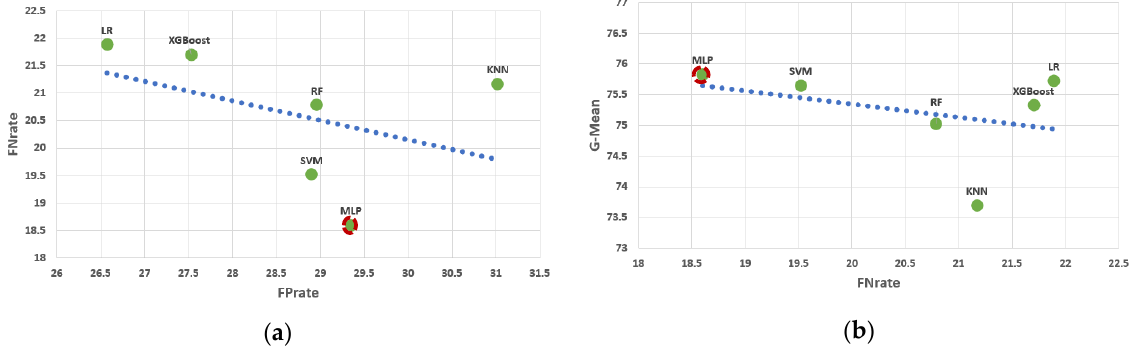
Figure 4. ( a ) Scatter plot of FP rate and FN rate . ( b ) Scatter plot of FN rate and G-Mean.